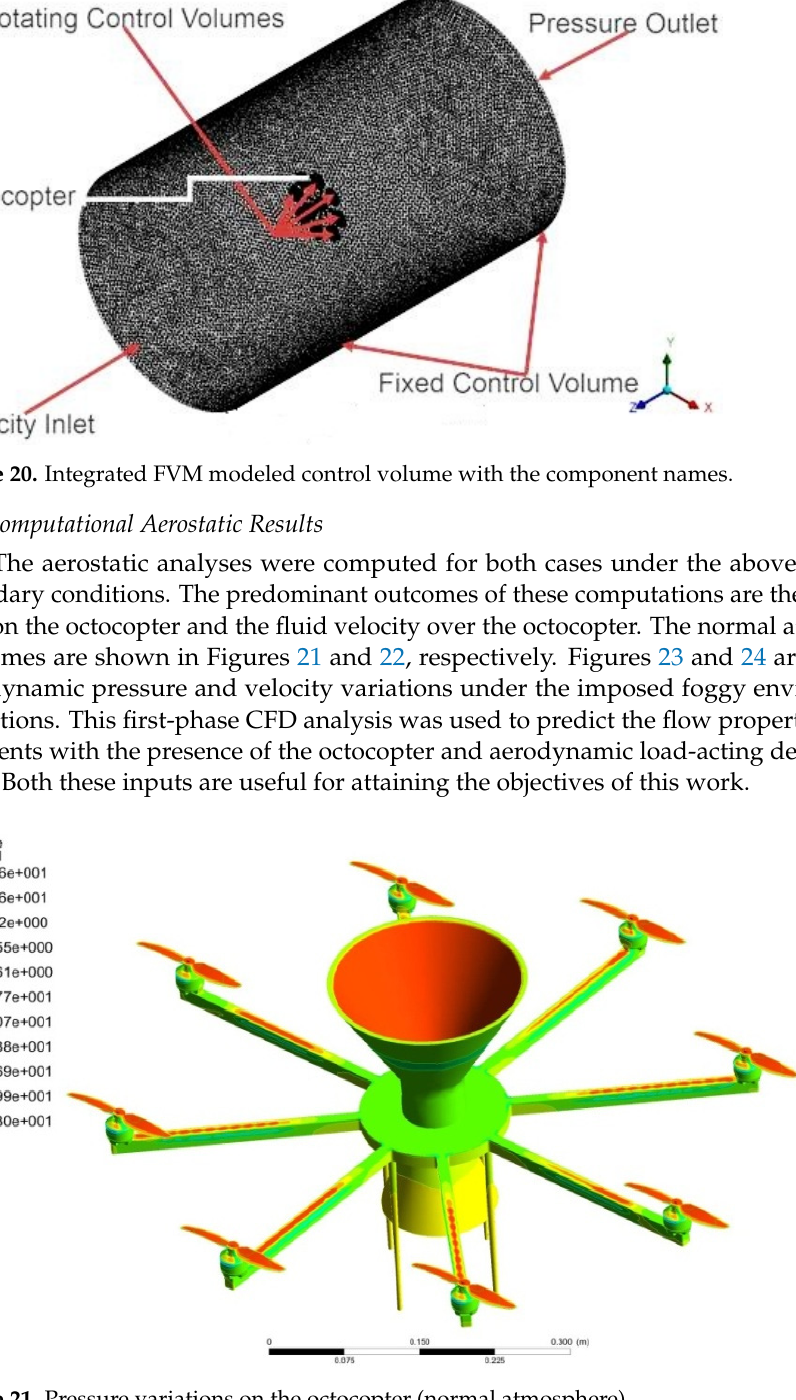
Figure 21. Pressure variations on the octocopter (normal atmosphere).